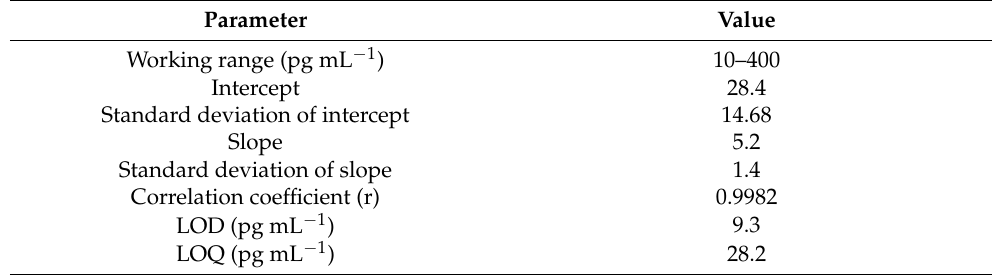
Table 4. Results linear regression analysis and validation parameters of the proposed CLEIA for BEV.